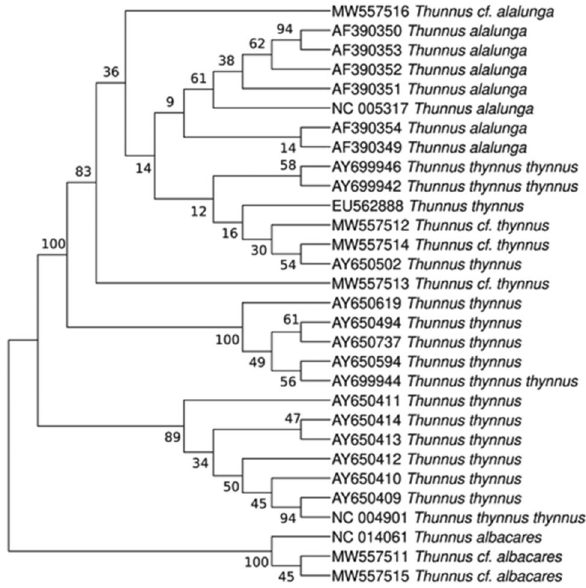
Figure 1. Maximum Likelihood tree built from problem sequences from Blanco-Fernandez et al. 2 (MW557511- 16) and reference tuna sequences from GenBank.